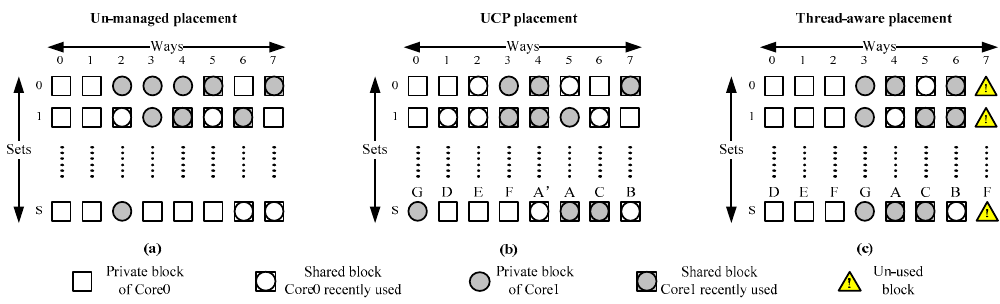
Figure 5. Data placement in shared caches with different cache partitioning schemes. ( a ) Un-managed placement, ( b ) UCP placement, ( c ) Thread-aware placement.